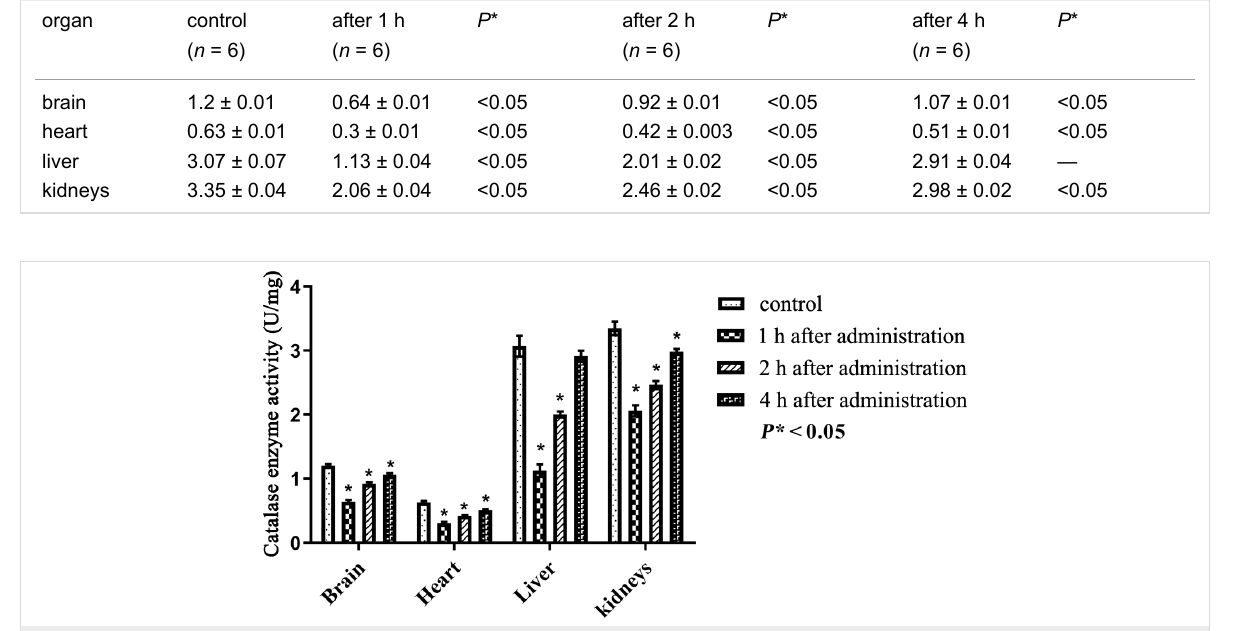
Glutathione is a tripeptide and, in its reduced form, acts as an active scavenger of free radicals produced as a result of lipid peroxidation. The concentration levels of the reduced glutathione in organs before and after the administration of